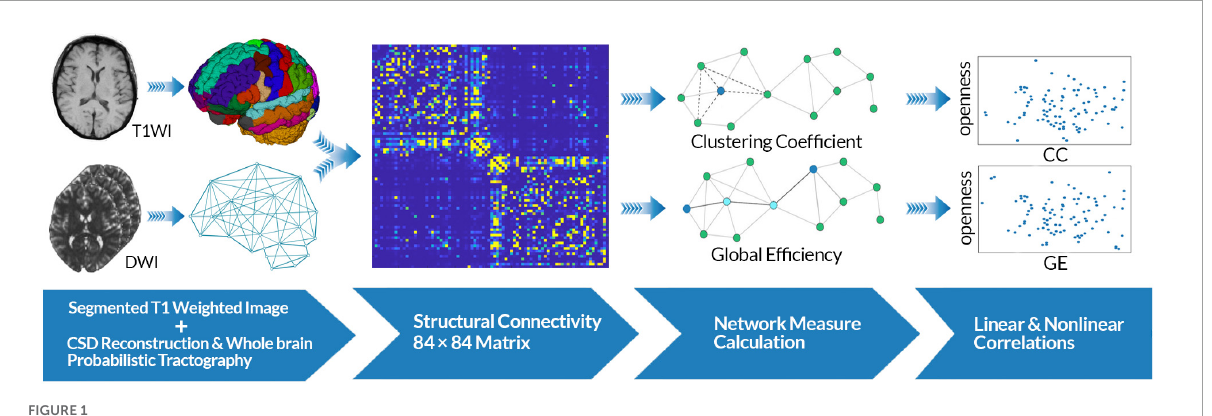
FIGURE1 Data analysis workflow. Constrained spherical deconvolution (CSD)-based whole-brain probabilistic tractography was performed using diffusion-weighted images as well as segmented T1w images. T1w images were segmented based on the Desikan-Killiany atlas for each subject. A whole-brain adjacency matrix (84 × 84) was constructed for each subject. Graph theoretical analysis was performed on each matrix to compute global efficiency (GE) and clustering coefficient (CC) as measures of integration and segregation in the brain structural networks. Linear and non-linear analyses were performed to evaluate the association between each network measure and openness score.